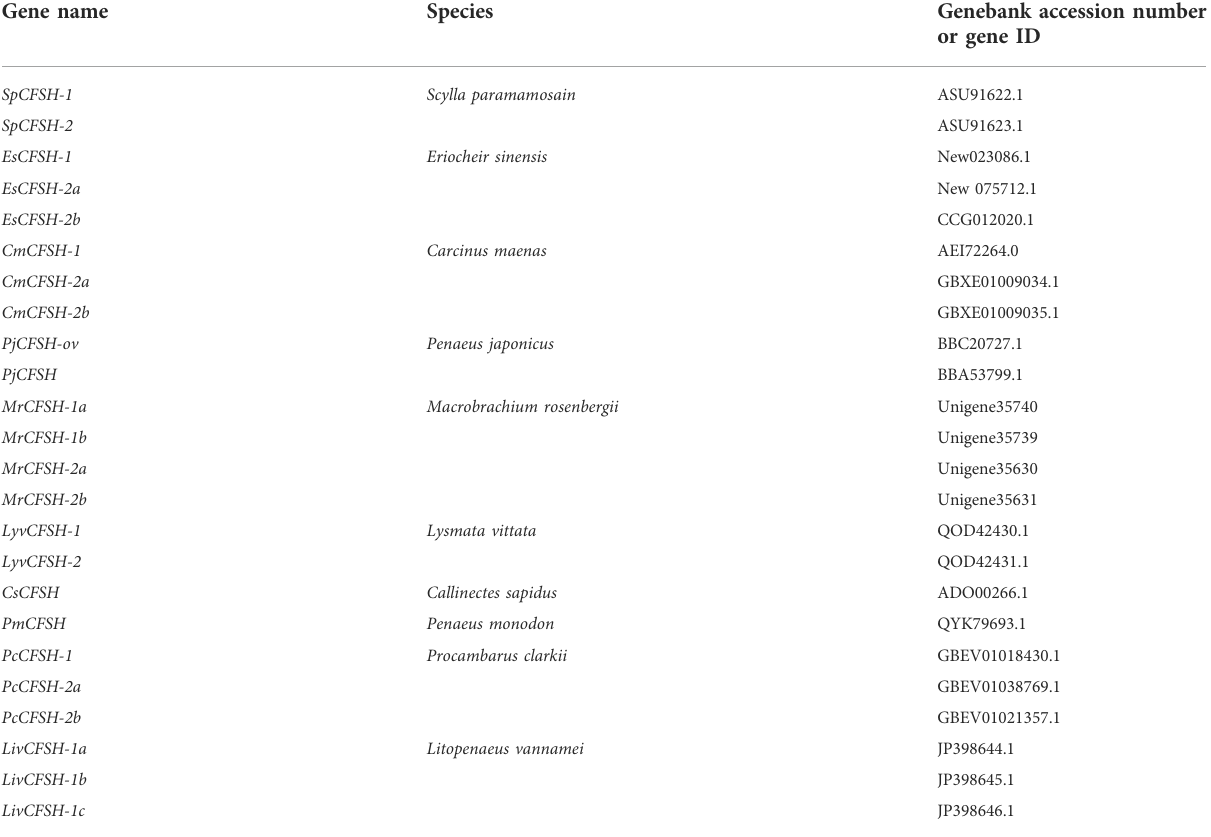
TABLE 2 The source of CFSHs for the multiple sequence alignment and phylogenetic